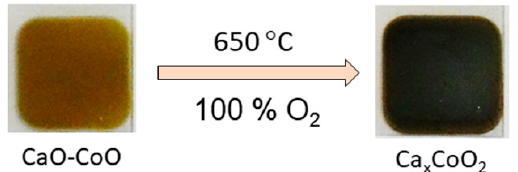
Figure 1. Optical image of as-deposited CaO–CoO film and annealed Ca x CoO 2 film.